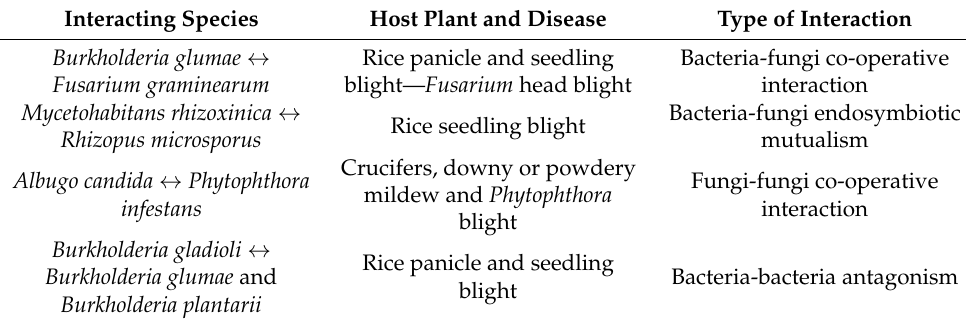
Table 1. Examples of the different types of interactions among plant pathogenic species. Interacting Species Host Plant and Disease Type of Interaction Burkholderia glumae ↔ Rice panicle and seedling Bacteria-fungi co-operative Fusarium graminearum